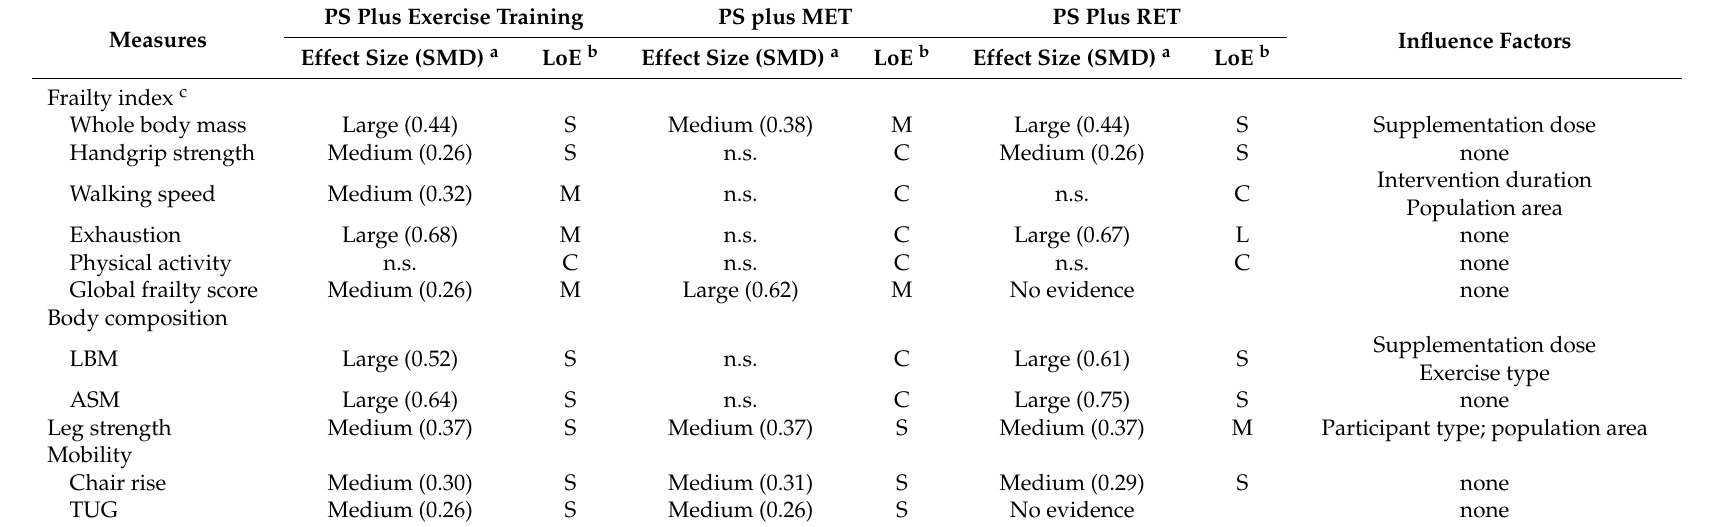
Table 6. Summary of effects of protein supplementation combined with exercise training on clinical outcomes for frail older